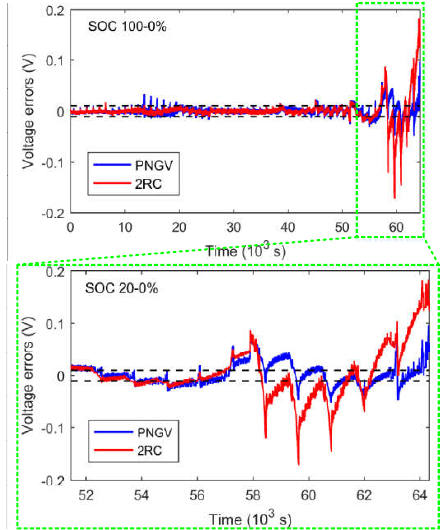
Figure 4. Comparison of identification results. ( a ) In the entire state-of-charge (SOC) area; ( b ) in the low SOC area (0–20%); and ( c ) in the high SOC area (20–100%).